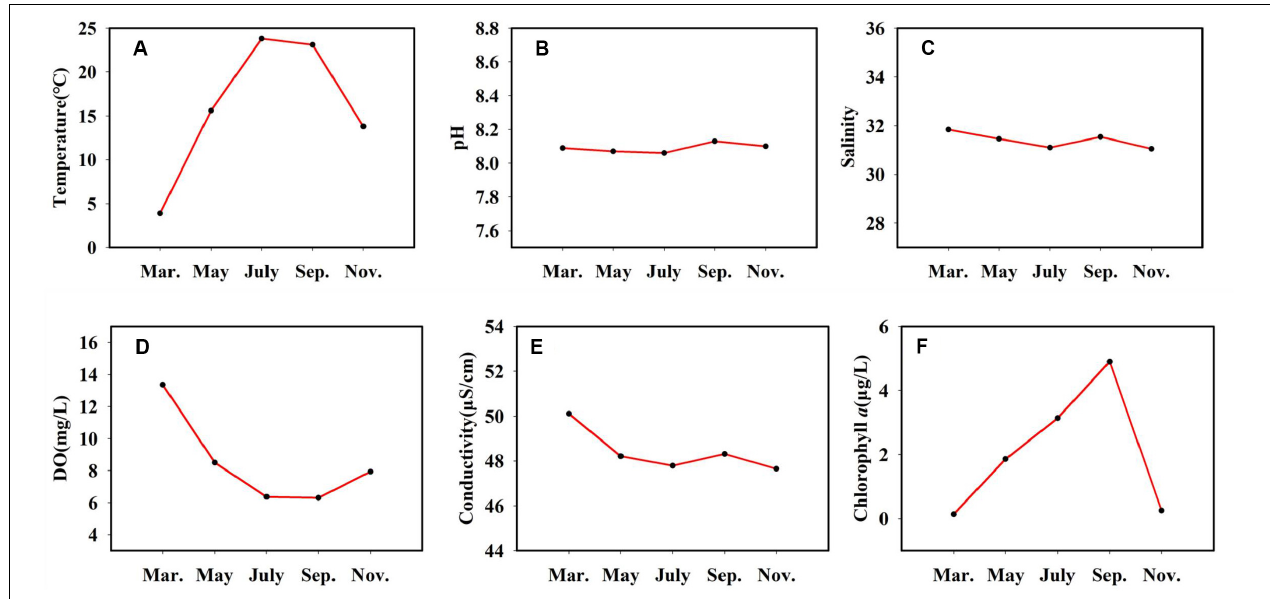
FIGURE 10 | Temporal variation of physicochemical parameters (monthly average values) in the surface seawater of Sishili Bay. (A) Temperature ( ◦ C), (B) pH, (C) salinity, (D) DO (mg/L), (E) conductivity ( µ S/cm), and (F) chlorophyll a ( µ g/L). TABLE 4 | Pearson correlation matrix for the monthly average concentrations of dissolved reactive Cu, Pb, Cd, and Zn and the physicochemical parameters in the surface seawater of Sishili Bay. Temperature pH